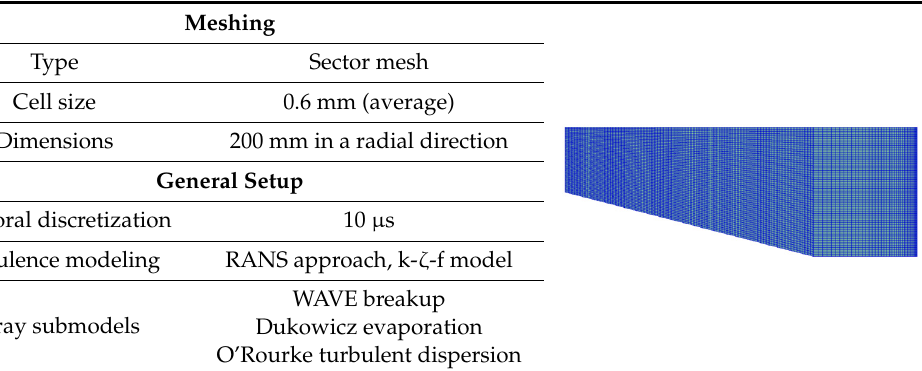
Table 2. Summary of the numerical setup for validating the injection modeling. The image on the right shows the mesh. Meshing